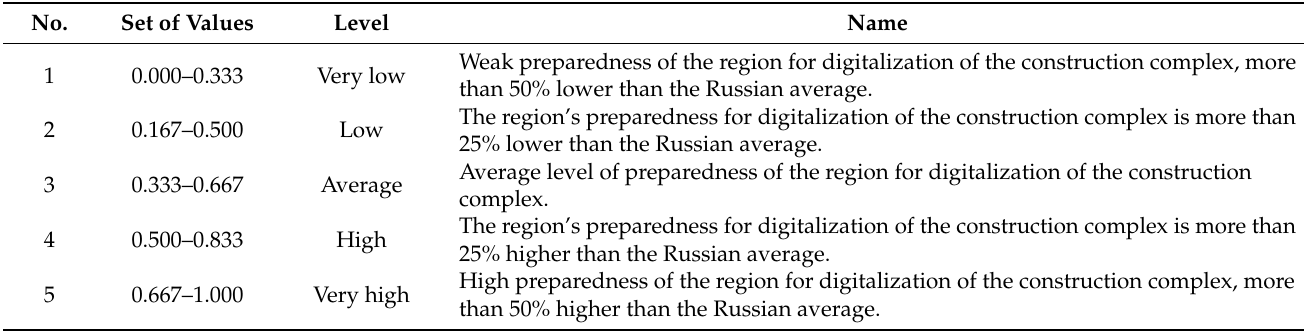
Table 4. Recommended fuzzy Y